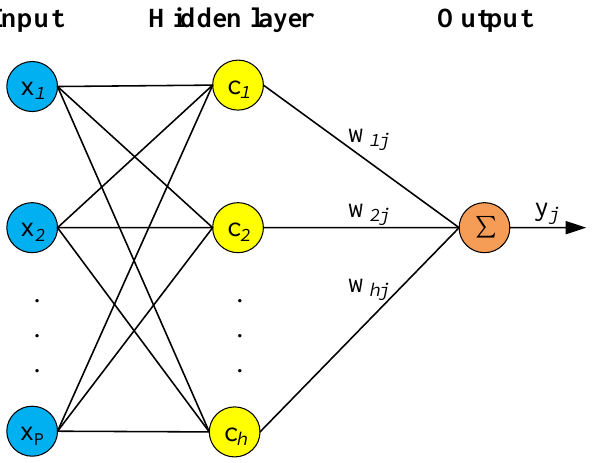
Figure 12. Schematic diagram of radial basis neural network.